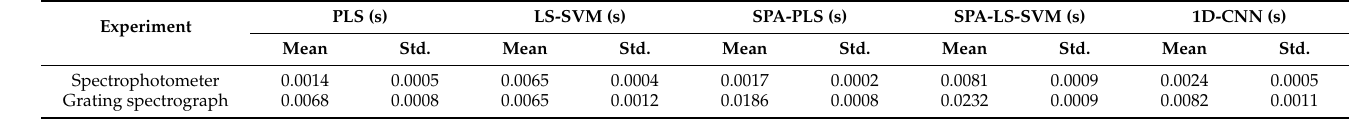
Table 6. Calculation time in the prediction process of different calibration models